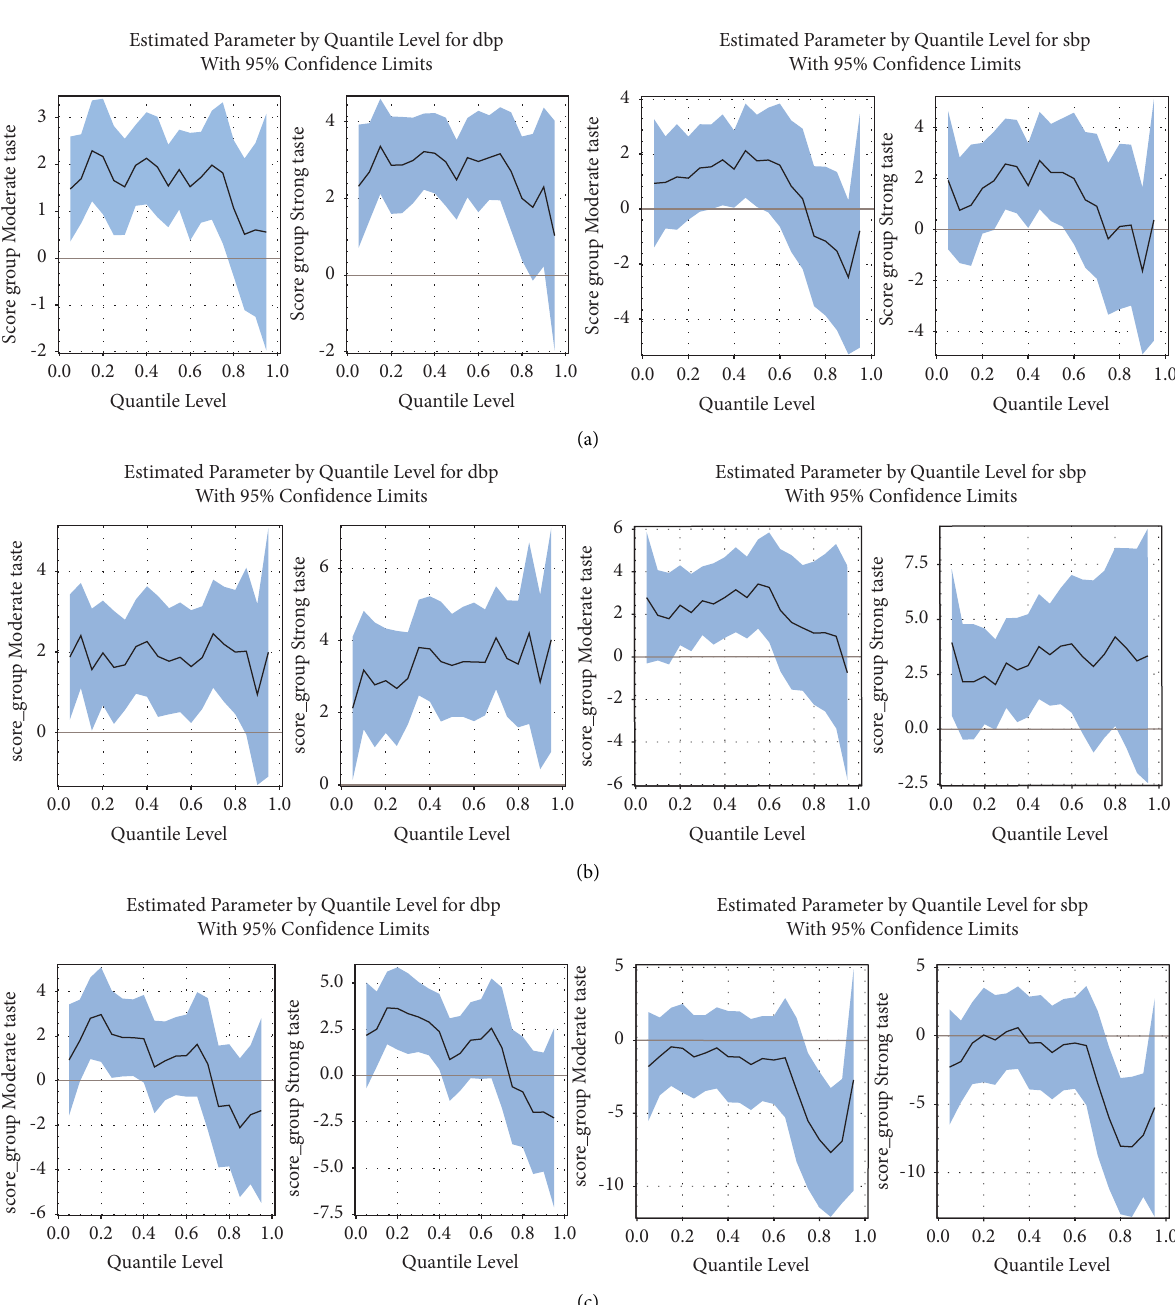
Figure 1: Te estimated parameter at the quantile level of DBP (left) and SBP (right) of moderate taste and strong tastes with 95% CI in all populations and stratifed by sex. (a) Te estimated parameter at the quantile level of DBP and SBP of taste preference groups in all populations. (b) Te estimated parameter at the quantile level of DBP and SBP of taste preference groups in females. (c) Te estimated parameter at the quantile level of DBP and SBP of taste preference groups in